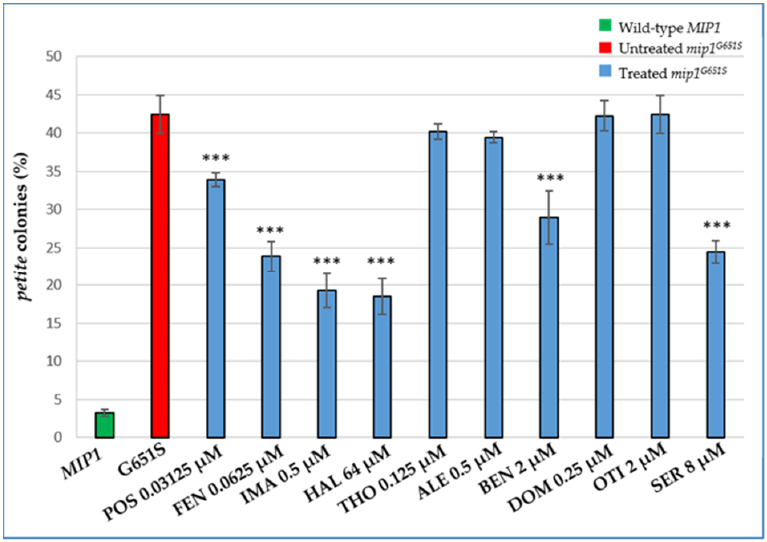
Figure 6. Beneficial effect of the identified drugs on petite colonies production of the mip1 G651S mutant strain. Cells were grown in YP medium supplemented with 2% glucose at 28 °C. More than 4000 colonies/strain were scored. All values are means of three independent experiments ± SD. Statistical analyses were performed using ANOVA followed by a Bonferroni’s post hoc test comparing treated (blue bars) versus the untreated mutant (red bar) in which the compound vehicle DMSO was added: *** p < 0.001.